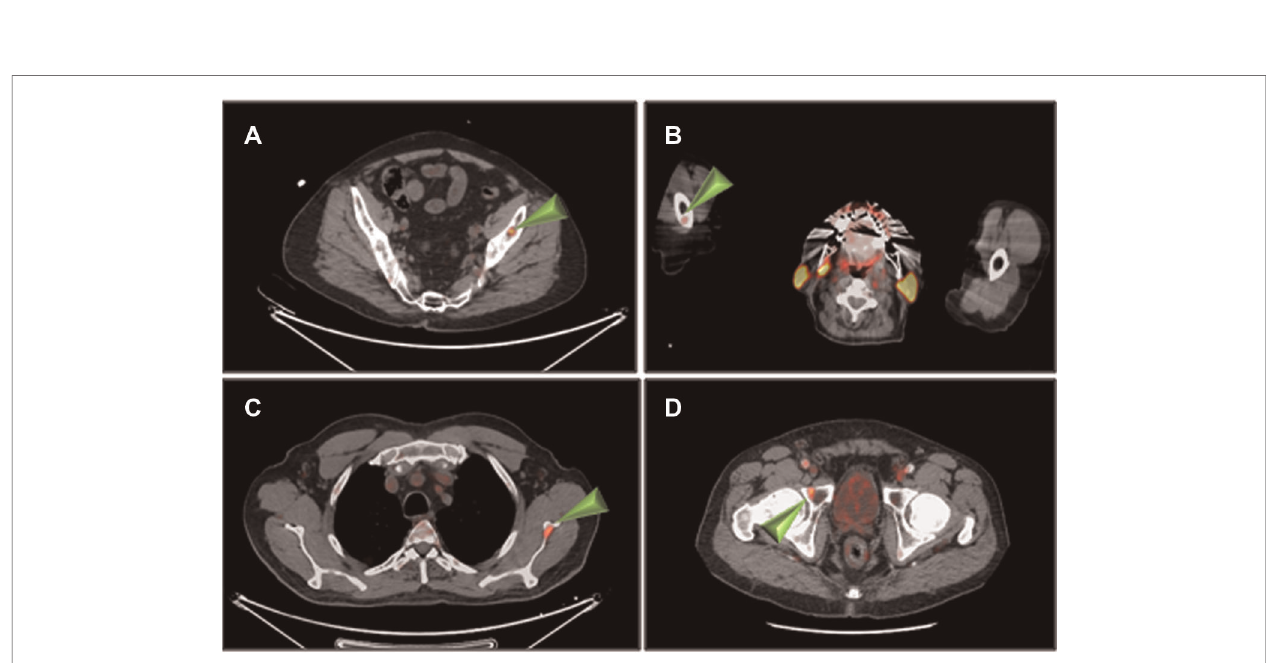
FIGURE 3 | Non-rib skeletal uptake of [ 18 F]PSMA-1007 (arrowheads) 1 h after injection. ( A ) patient #1 (left iliac), ( B ) patient #1 (right humerus), ( C ) patient #3 (left scapula), ( D ) patient #10 (right pubic